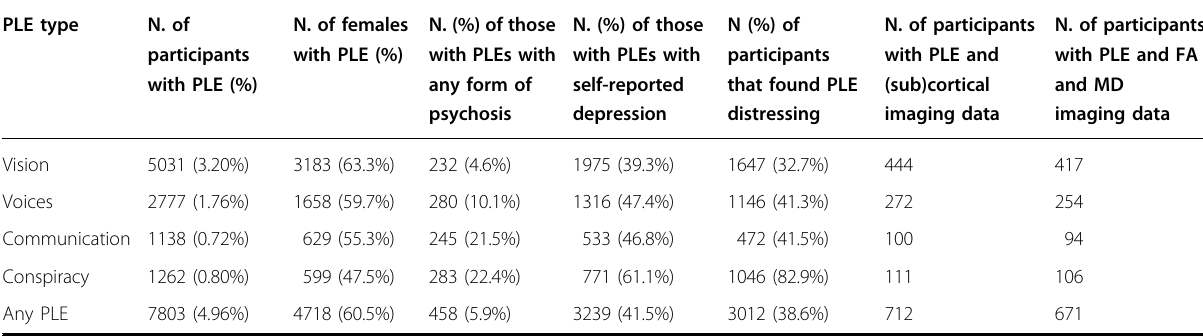
Table 2 Prevalence of the different types of PLE in those that completed the UKB mental health questionnaire ( N = 157,366 with 89,101 women) (see Supplementary Tables 1 and 2 for the numbers on different imaging data types). PLE